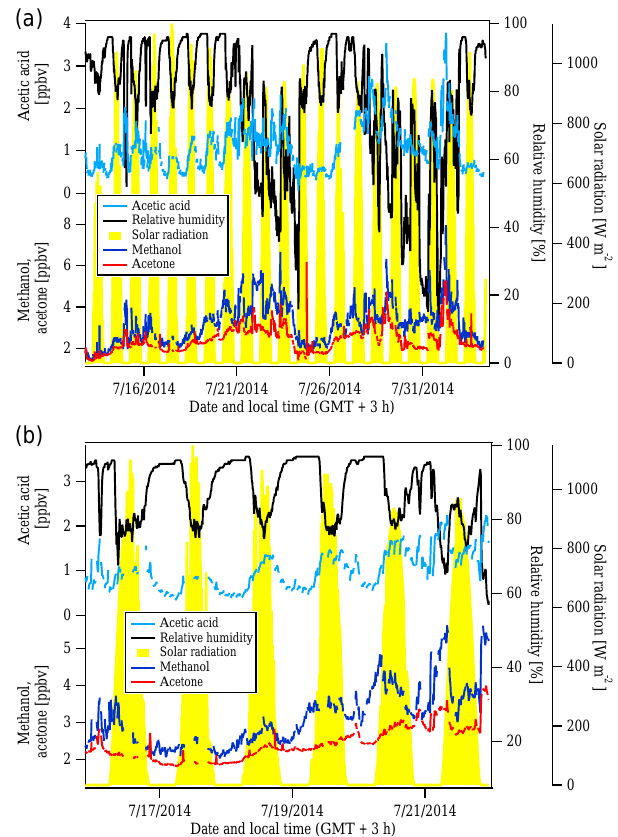
Figure 5. Mixing ratios of acetic acid, acetone and methanol in ppbv, relative humidity in % and solar radiation in Wm − 2 (10min mean values) as a function of time. The lower panel zooms in from 16 to 21